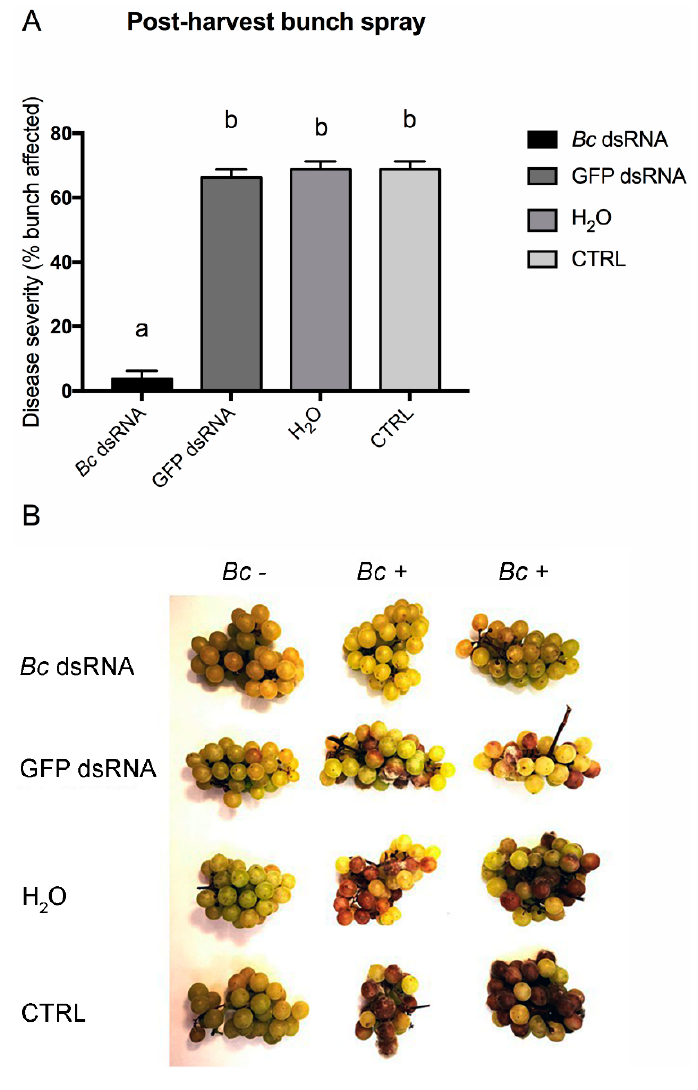
Figure 5. Disease severity on bunches recorded for the in vivo high pressure spray application method in postharvest bunches. Percentage of berries affected following Bc dsRNA, GFP dsRNA, H 2 O application and in untreated CTRL samples. Different lowercase letters above bars indicate significant differences as determined by Tukey HSD test ( p ≤ 0.05) ( A ). Overview of representative samples for each condition tested. One bunch was maintained as uninoculated control ( Bc -) and two inoculated ( Bc +) bunches of cv. Moscato are shown ( B ).